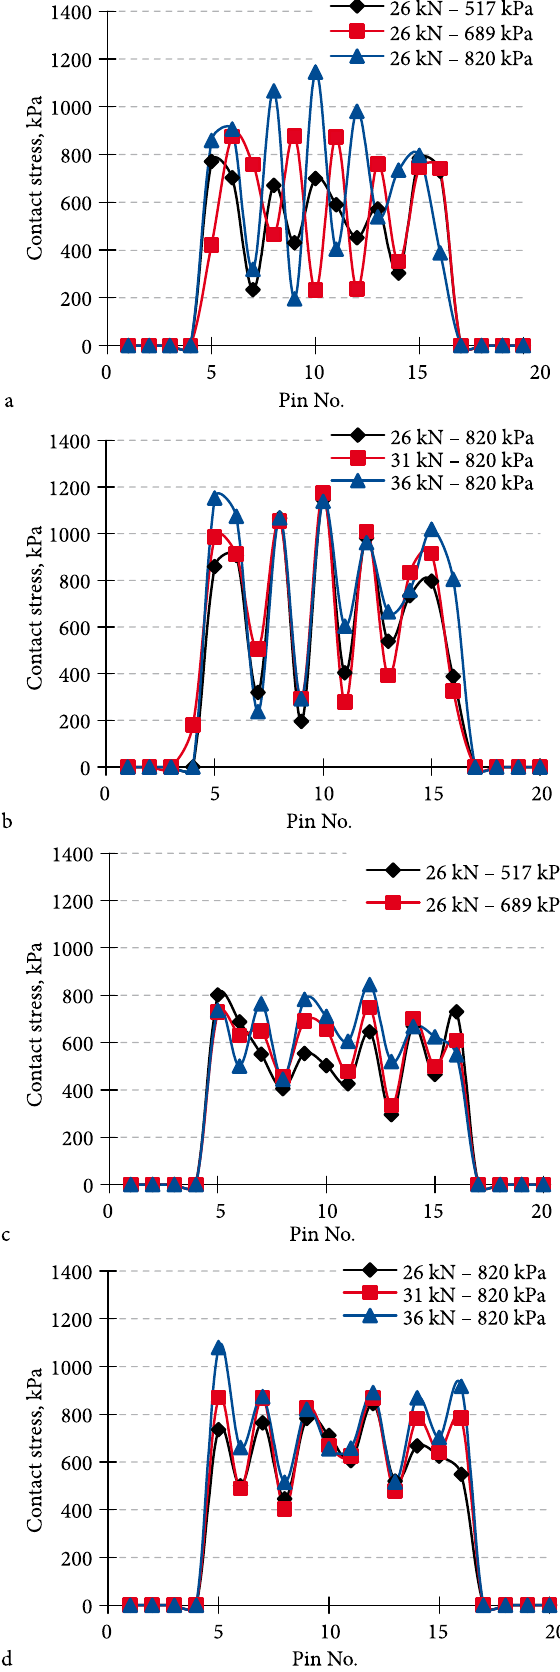
fig. 2. Distributions of tire contact stresses: a, b – 11 R 22.5 radial tire; c, d – 10 × 20 bias ply